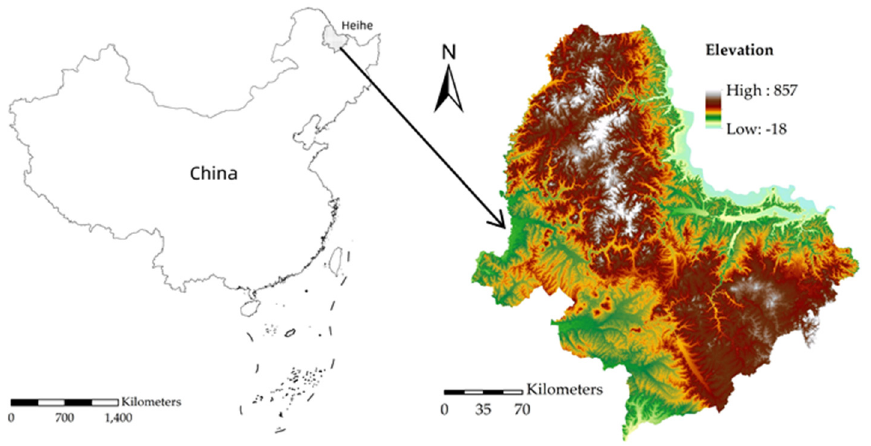
Figure 1. The topography of the study area.